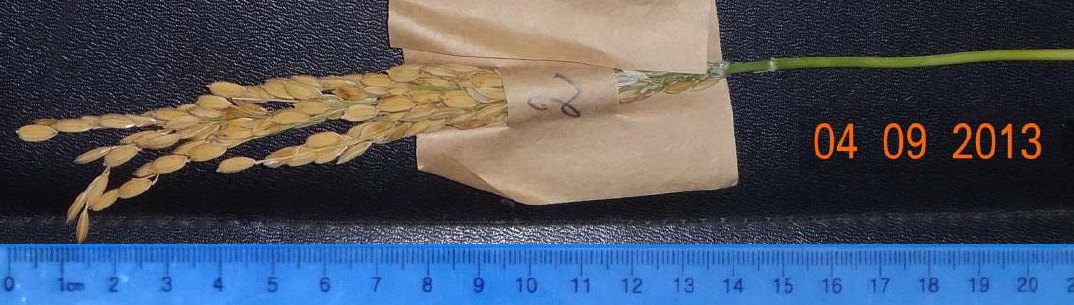
Figure 1. Panicle of the early-ripening line 1225/13.